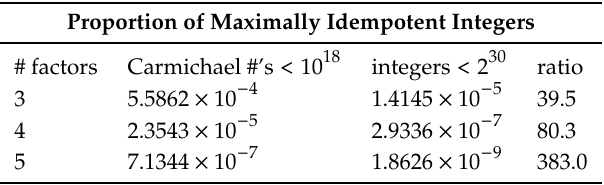
Table 3. Maximally idempotent integers among the Carmichael